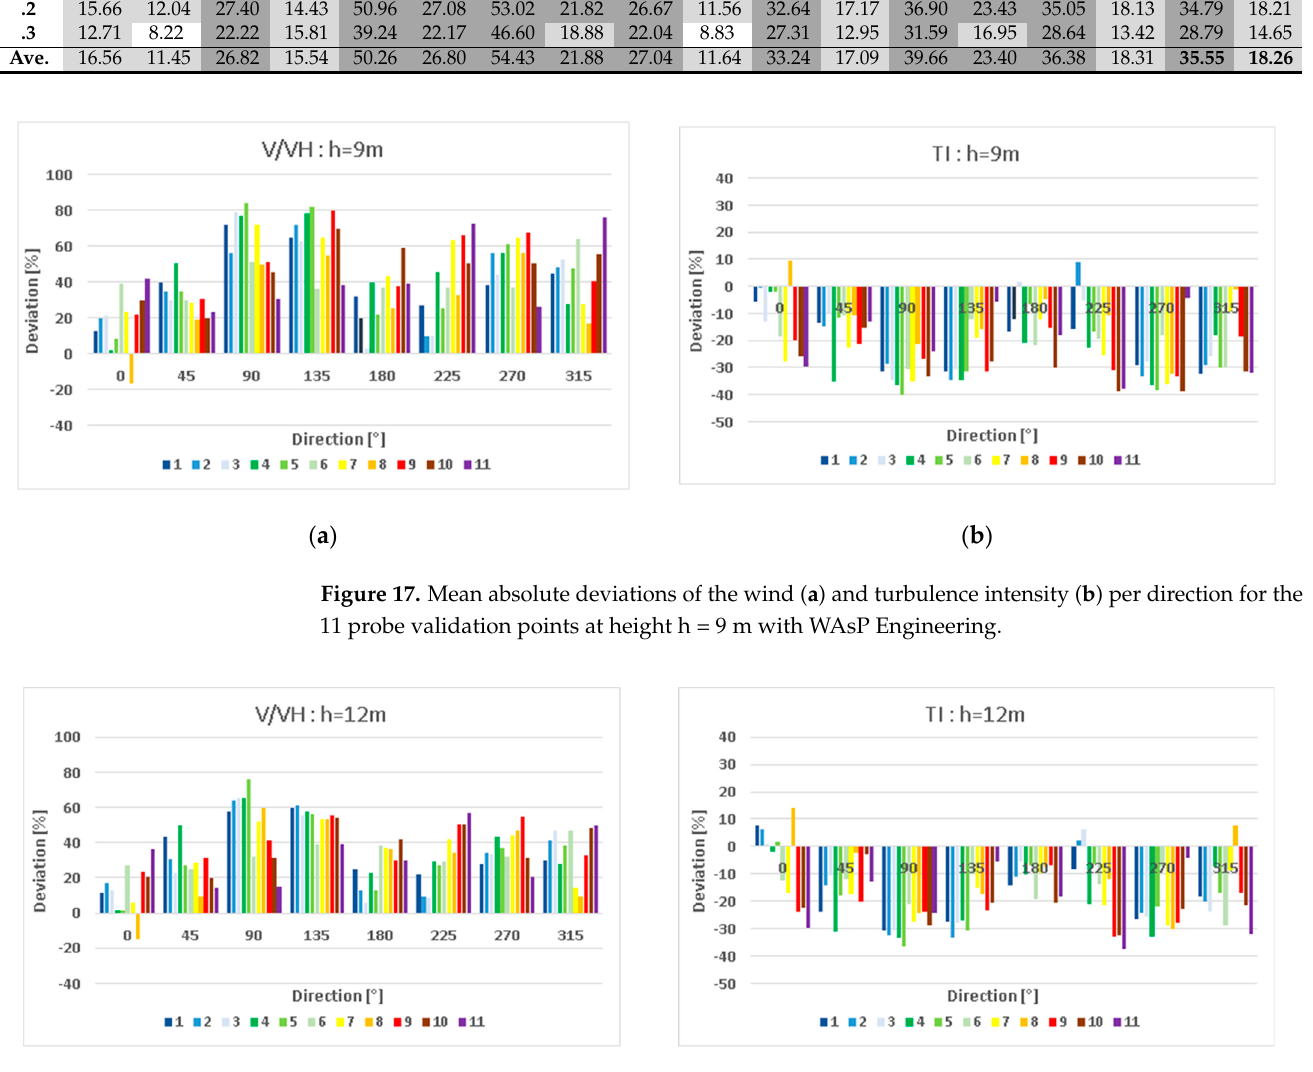
( b ) Figure 19. Mean absolute deviations of the wind ( a ) and turbulence intensity ( b ) per direction for the 11 probe validation points at height h = 17 m with WAsP Engineering.